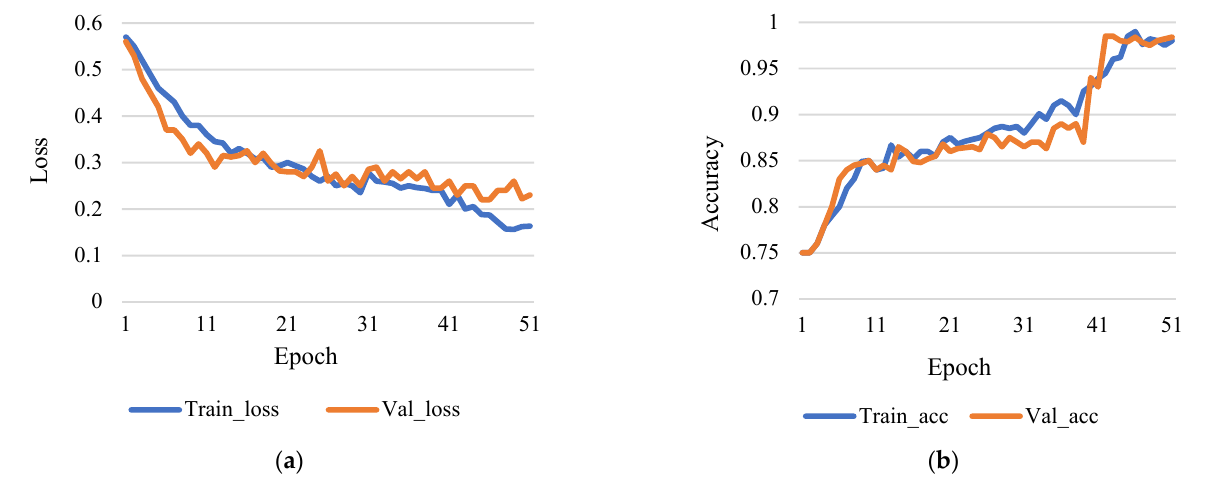
Figure 7. ( a ) Training loss vs validation loss (rate of learning 0.001 and epoch 100). ( b ) Training accuracy vs validation accuracy (rate of learning 0.001 and epoch 100).